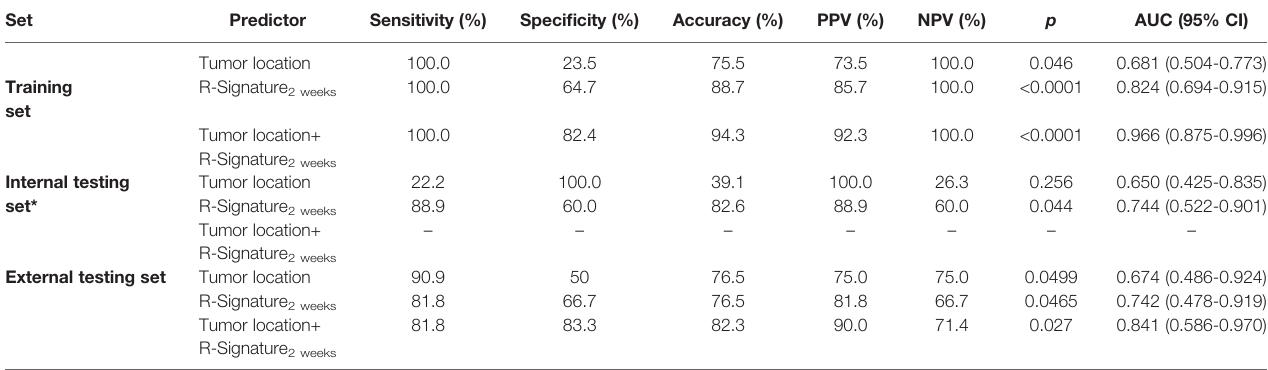
TABLE 3 | Performance of radiomics signatures and models for predicting treatment response in the training, internal, and external testing sets.